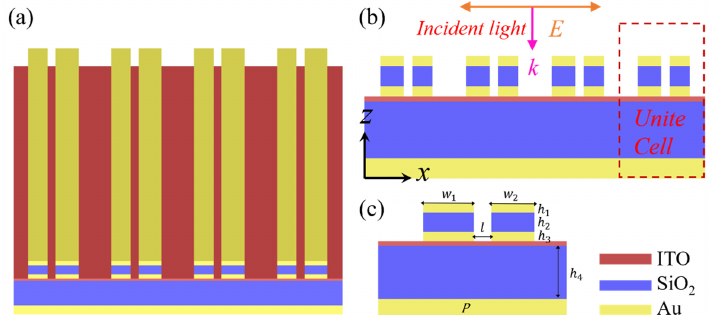
Figure1. ( a )Schematicofthemetal-insulator-metal-insulator-metal(MIMIM)structure; ( b )cross-section Figure 1. ( a ) Schematic of the metal ‐ insulator ‐ metal ‐ insulator ‐ metal (MIMIM) structure; ( b ) cross ‐ section of the MIMIM structure and the incident light configuration; ( c ) cross ‐ section of the MIMIM structure of the MIMIM structure and the incident light configuration; ( c ) cross-section of the MIMIM structure of a unit cell with dimension and material labels. of a unit cell with dimension and material